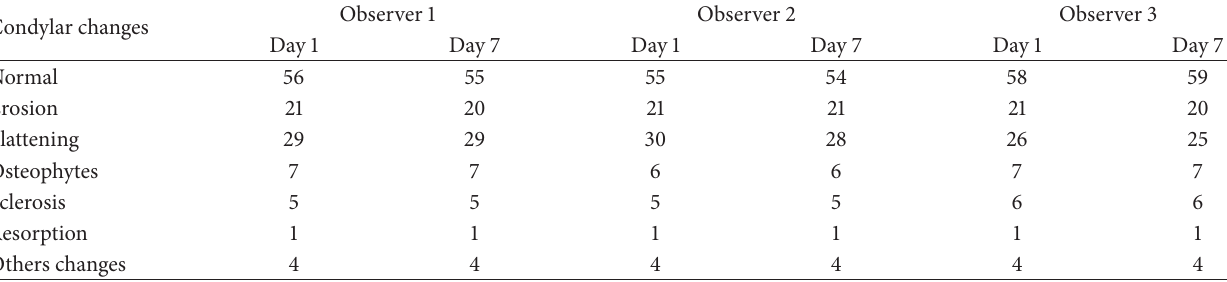
Table 3: Bony changes seen by three observers in OPG.